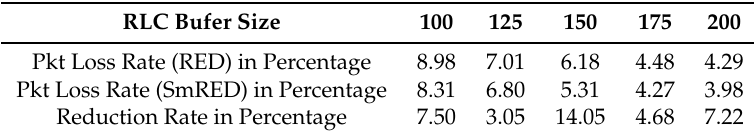
Table 2. Packet Loss Rate in the High Traffic Load Scenario.